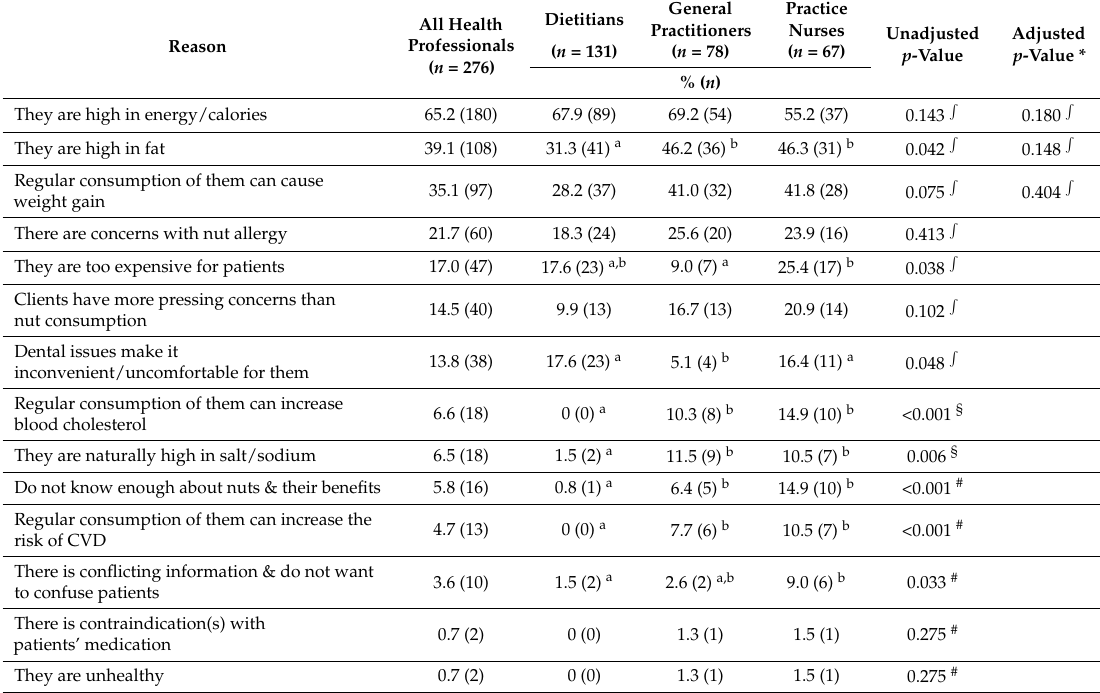
Table 5. Reasons for advising some patients to eat fewer nuts and nut